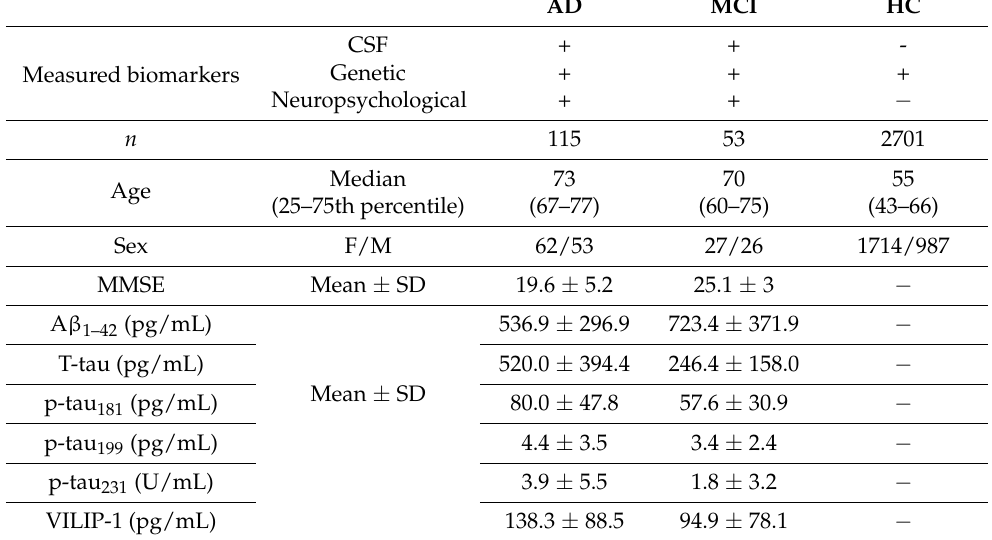
Table 1. Demographic data and biomarkers in different cohorts.